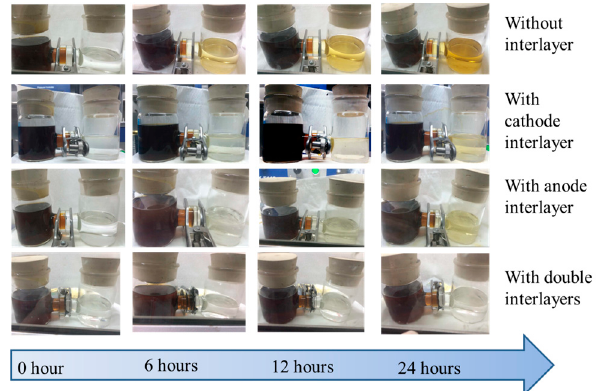
Figure 6. The optical images of the diffusion process of polysulfides of separator, cathode interlayer with separator, anode interlayer with separator, and cathode anode interlayers with separator in H type cell after variable resting times.